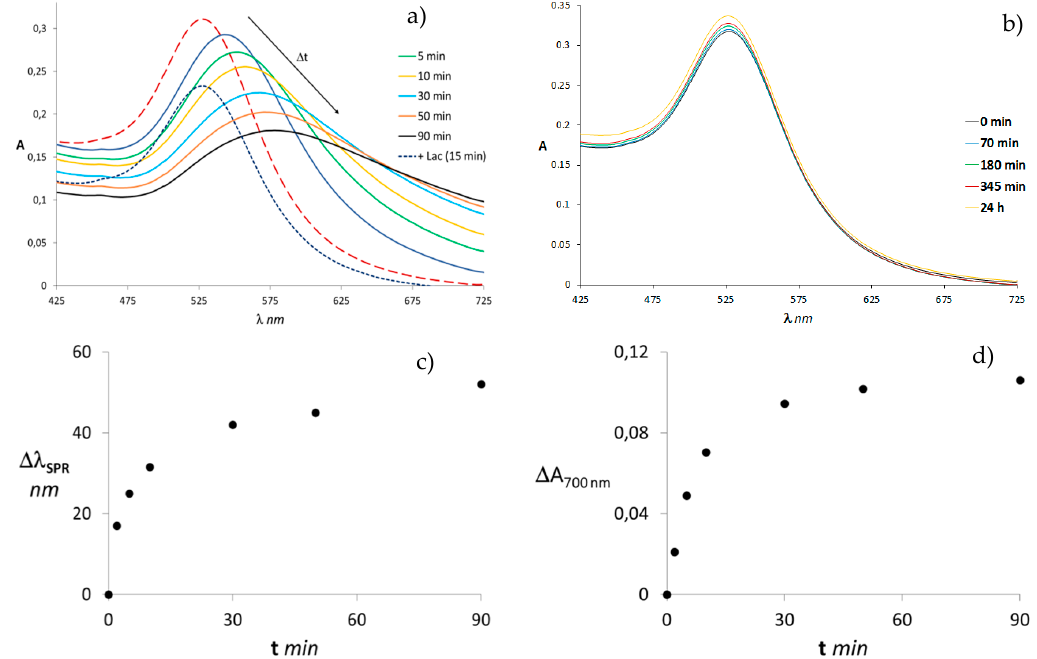
Figure 6. ( a ) UV–visible spectra of AuNP@Fc-Lac (2 nM) in a phosphate bu ff er of 10 mM, pH 7.2 with 20 mM NaCl in the presence of Gal-3 (10 µ M) recorded at di ff erent times after addition of the lectin along with the UV–visible spectrum of this mixture after the addition of an aqueous saturated D-Lactose solution (dashed blue). ( b ) UV–visible spectra of AuNP@Fc-Lac (2 nM) in phosphate bu ff er 10 mM, pH 7.2, in the presence of BSA recorded at di ff erent times. Variation of ∆ λ SPR ( c ) and absorbance at 700 nm ( d ) over time.